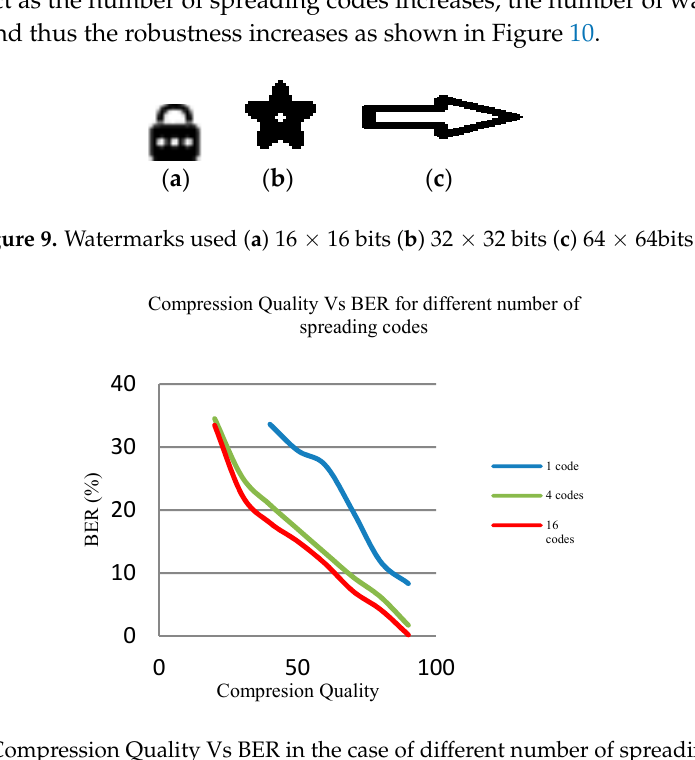
Figure 10. Compression Quality Vs BER in the case of different number of spreading codes.